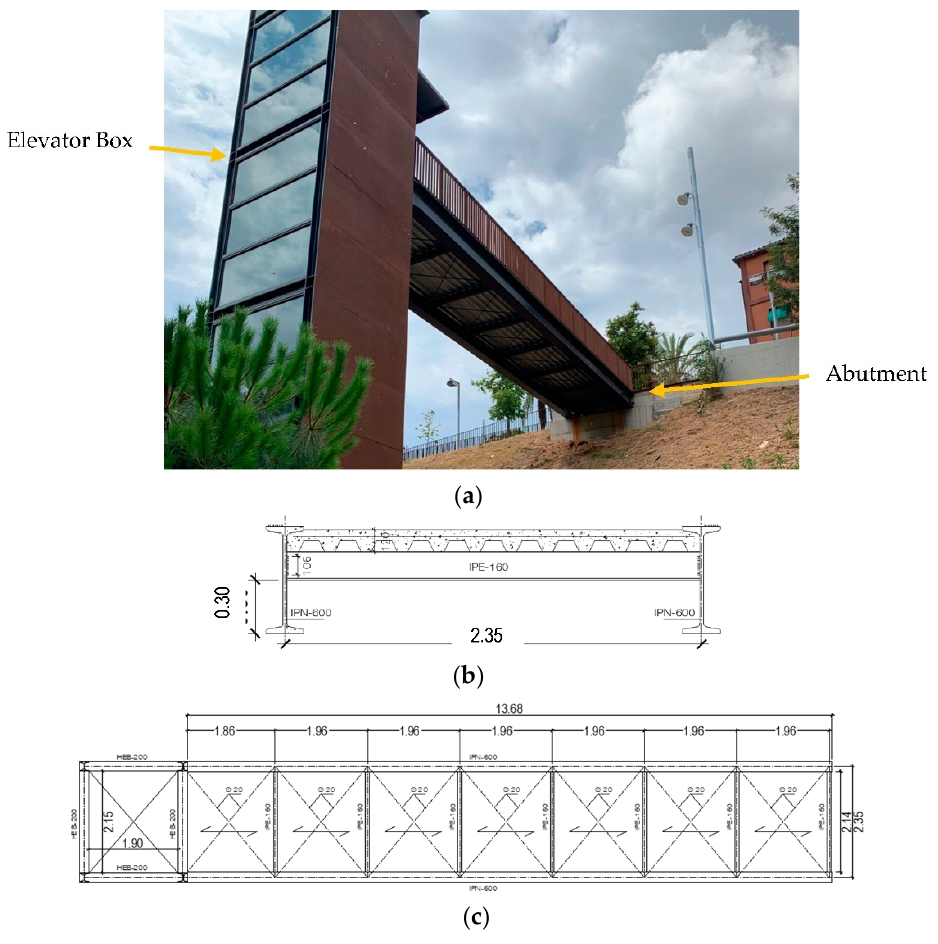
Figure 5. Polvorines footbridge: ( a ) a photo of the bridge, ( b ) the bridge’s cross-section, and ( c ) the bridge’s plan (all units are in meters).